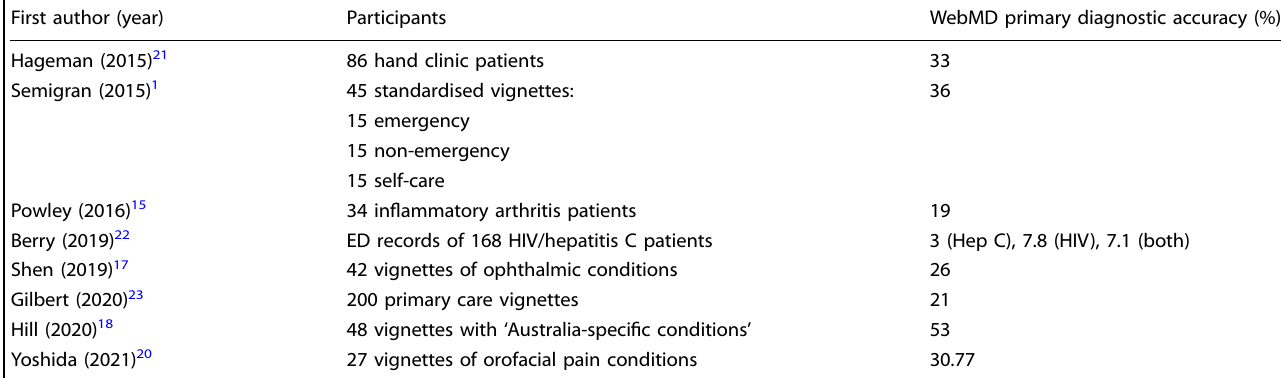
Table 3. Primary diagnostic accuracy of WebMD in included